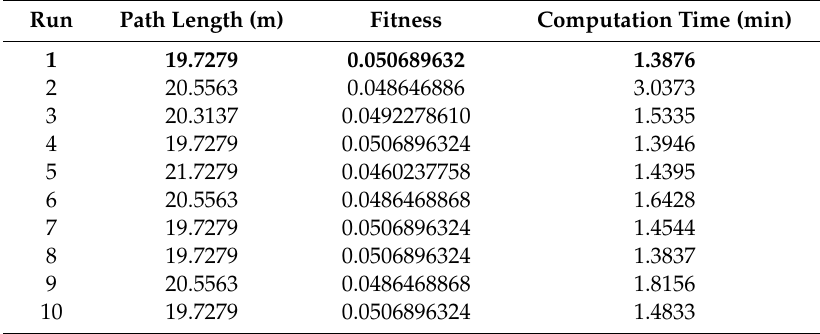
Table 4. Simulation results for the grid-based dynamic environment 1 using the ABACO